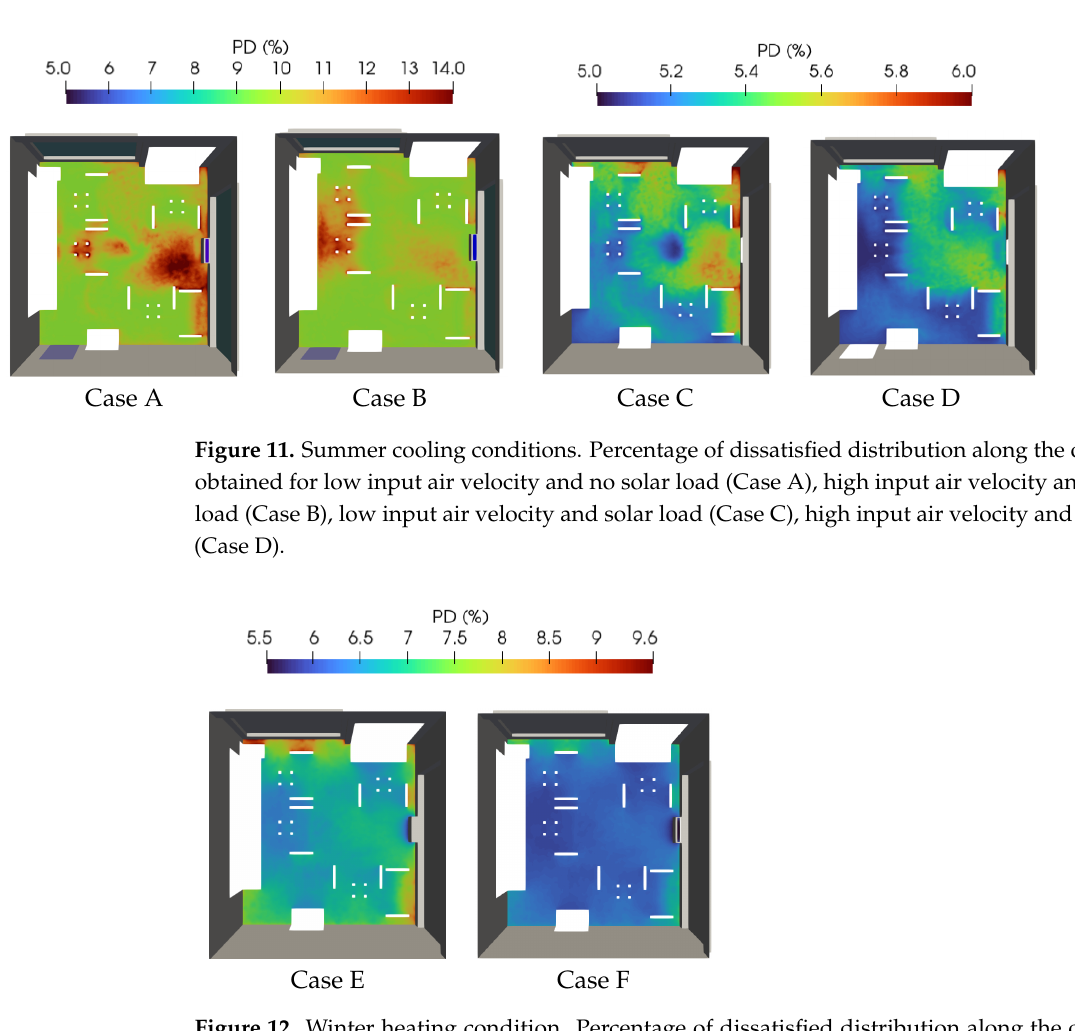
Figure 12. Winter heating condition. Percentage of dissatisfied distribution along the office floor obtained with low input air velocity (Case E) and high input air velocity (Case